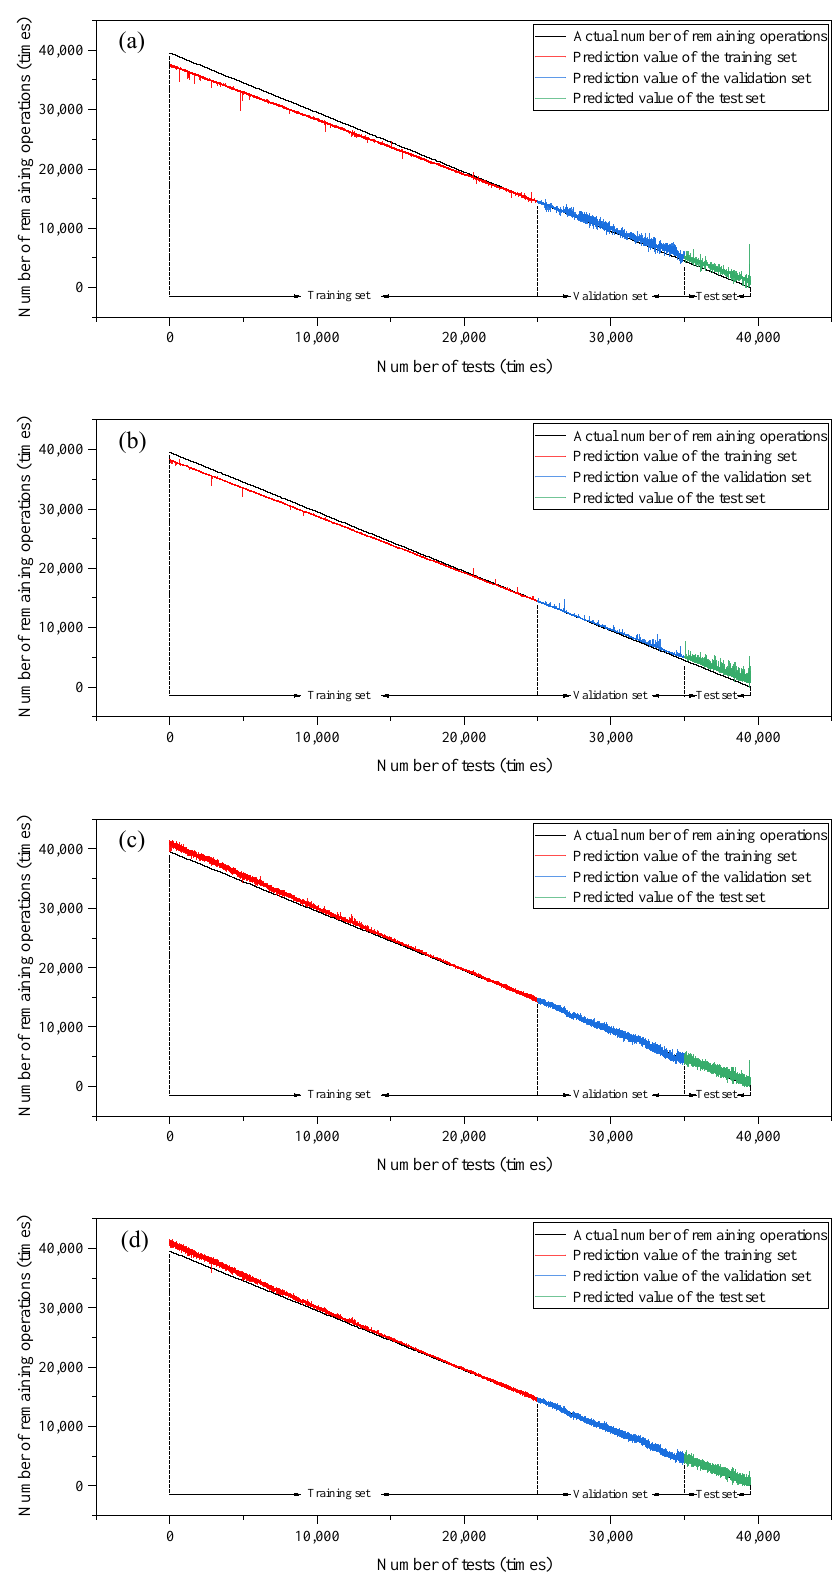
Figure 20. Comparison of prediction results before feature selection. ( a ) RNN, ( b ) LSTM, ( c ) GRU, ( d )